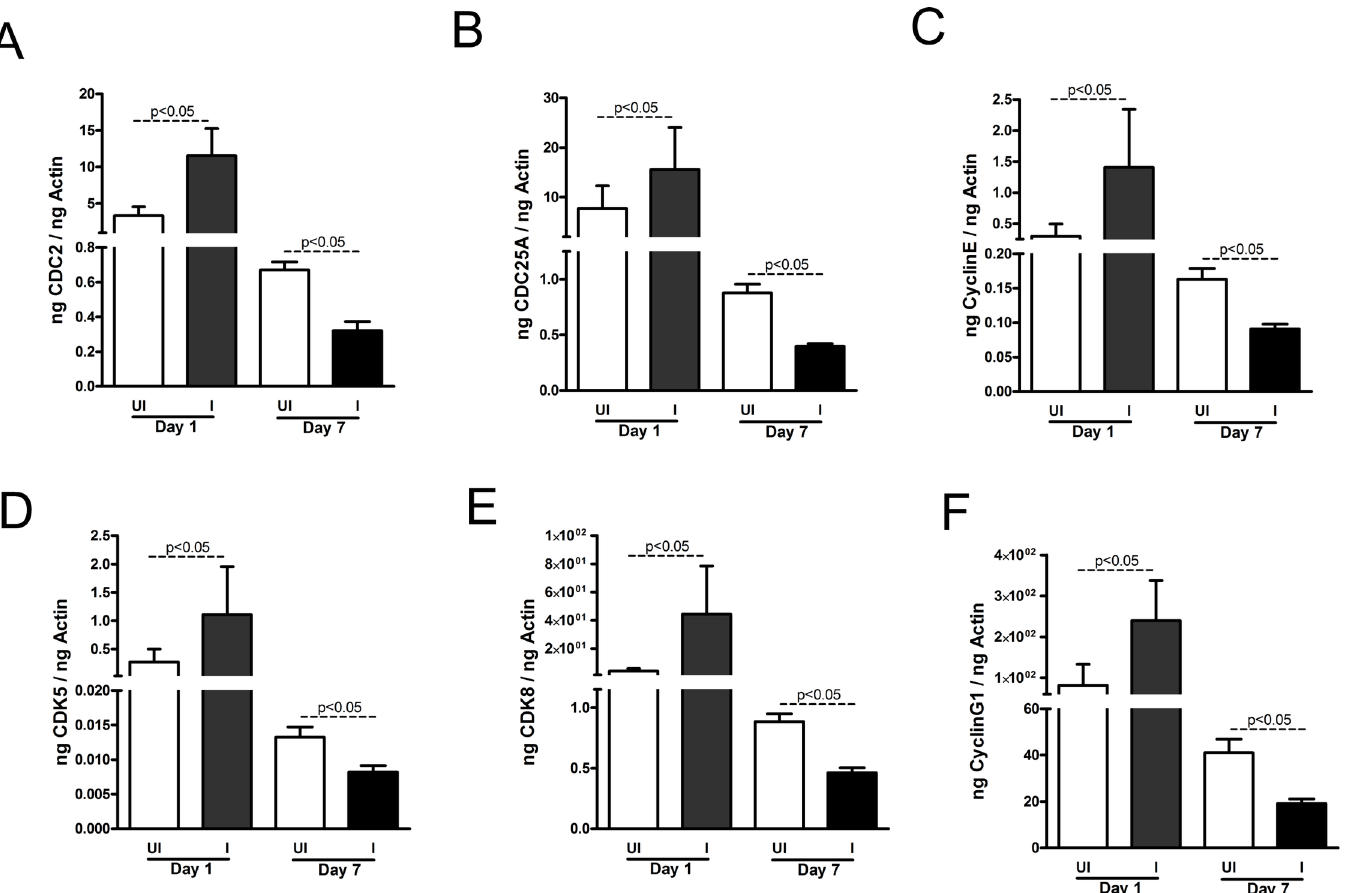
Fig 2. A . phagocytophilum infection alters cell cycle gene expression in MEG-01 cells. QRT-PCR analysisshowinglevels of CDC2 (A), CD25A (B), cyclin E (C), CDK5 (D), CDK8 (E) and cyclin G1 (F) in uninfected(UI) and A . phagocytophilum -infected(I) MEG-01 cells at days 1 and 7 p.i. The mRNA levels of cell cycle geneswere normalized to humanbeta-actin mRNA levels. QRT-PCR was performed on samples generatedfrom three independentexperiments (3 samples/experiment) and analyzedin duplicates. The P value (P < 0.05)calculatedfrom Student’s t test was considered significant.